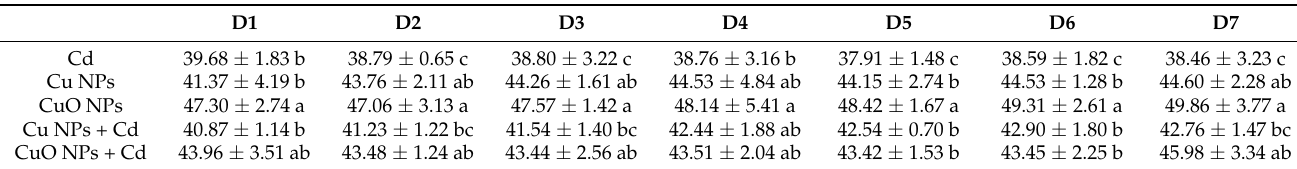
Table 1. Effect of Cu NPs, CuO NPs and Cd on photosynthetic rate of Brassica from 1 to 7 days. The means are averaged from three replicates, and the error bars correspond to the standard deviations of the three values. Different letters above each column indicate a significant difference among treatments in the same group ( p <